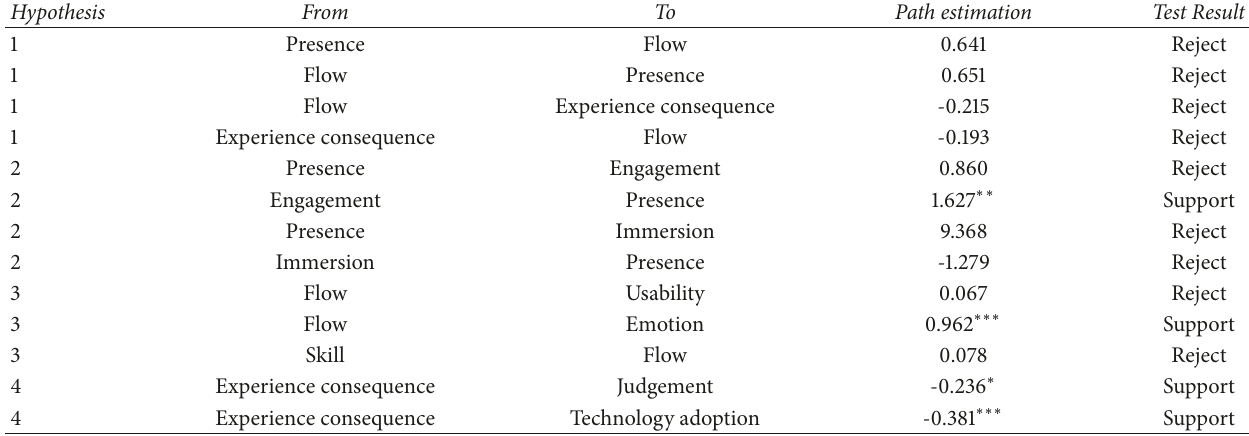
Table 2: Evaluation of the structural model with supported and rejected paths estimations.